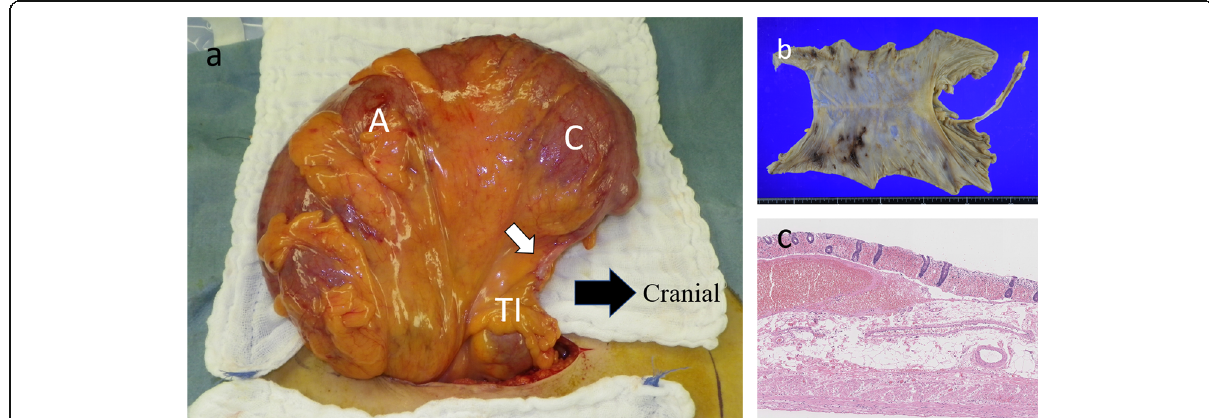
Fig. 5 Operative and pathological findings of the second surgery. The operative findings ( a ) showed that the cecum (C) and the appendix (black arrow) were in the upper abdominal cavity, and the ascending colon ran from the cranial to the caudal side. The colon was pulled out from the abdominal cavity without any mobilization. The diagnosis was cecum volvulus with 180° rotation, and the tract was resected from the terminal ileum to the remaining transverse colon ( b ). Pathological findings ( c ) revealed a thinned intestinal wall and edema at the mucosal and submucosal layers, which indicated an acute circulating